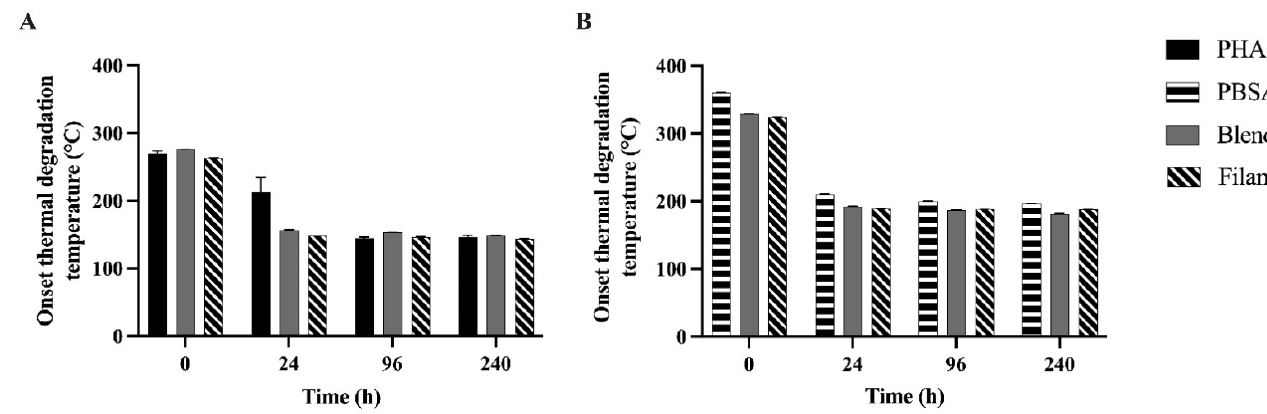
Figure 4. Onset degradation temperature of PHA, PBSA, Blend, and Filament treatments after fermentation in rumen fluid for 0, 24, 96, and 240 h in F57 bags separated by: ( A ) PHA component and ( B ) PBSA component. Onset thermal degradation temperature ( ◦ C) of treatments were determined to be the temperature at which 5% of the initial mass degraded. For the PHA components, time was the only significant parameter. Time: p < 0.0001. For the PBSA components: Treatment: p < 0.0001, Time: p < 0.0001, Treatment × Time: p < 0.0001. Data are shown as least squared means of treatments in duplicate (LSM ± SEM).